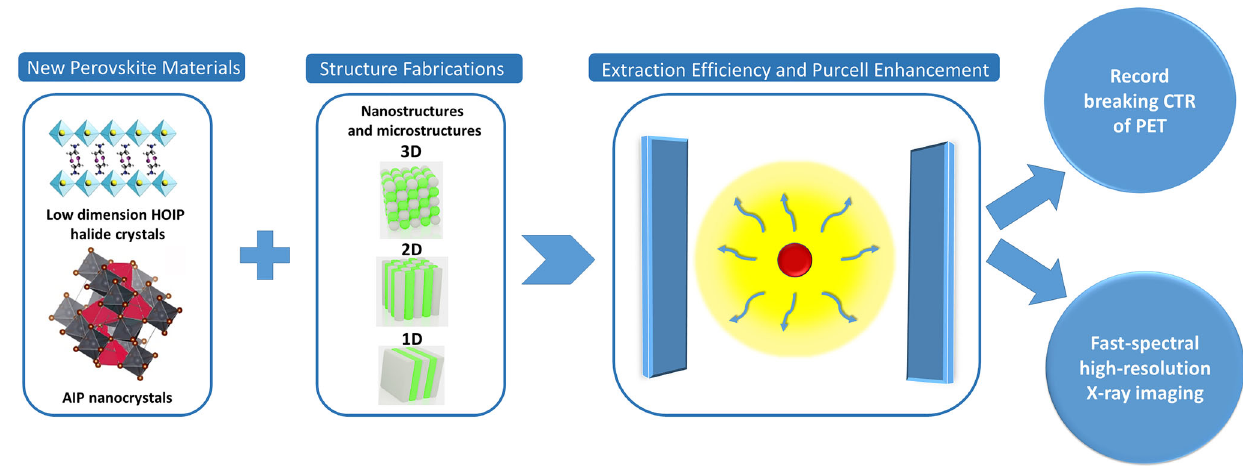
Fig. 4 Research roadmap of high light-yield and fast perovskite scintillators. New perovskite materials with state-of-the-art photonic nanostructures will help to revolutionize PET and fast-spectral high-resolution X-ray